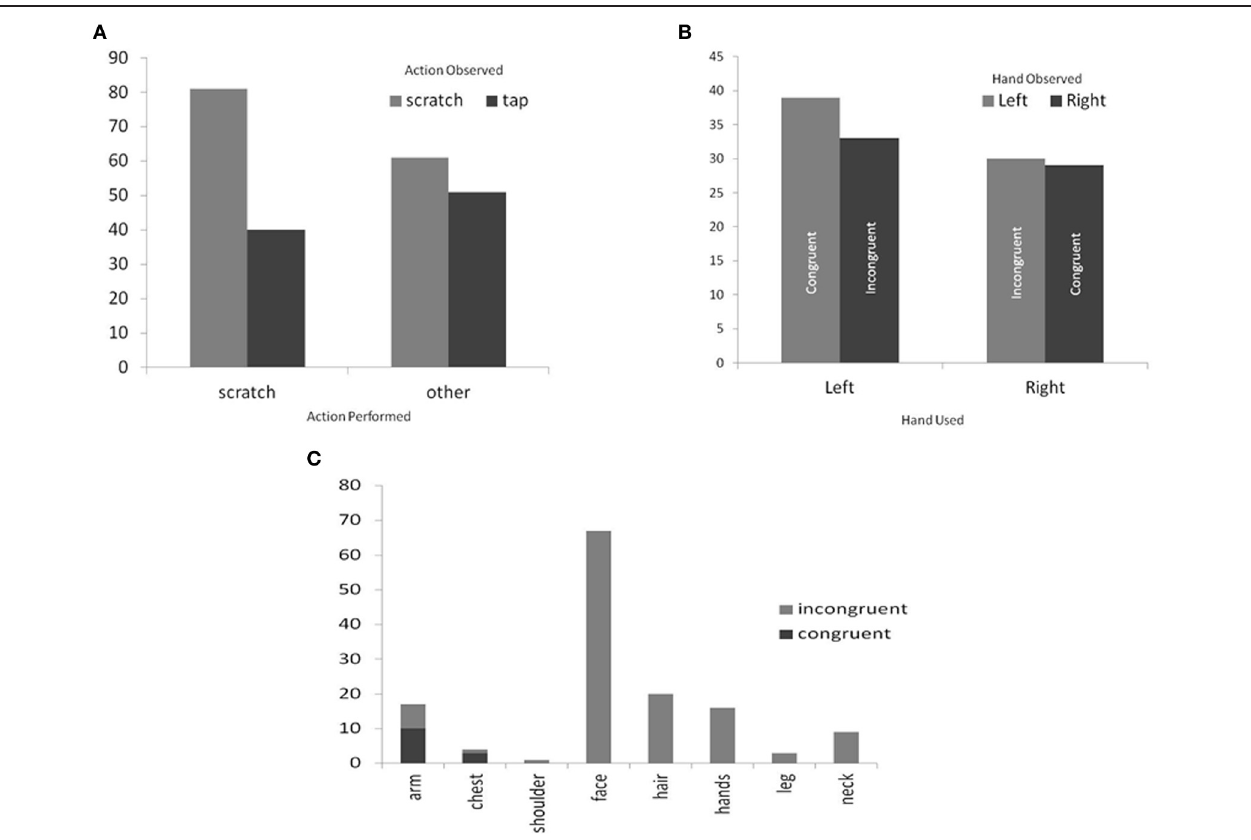
FIGURE 1 | Frequency counts for (A) different actions performed in relation to the current action observed (B) the hand used to perform scratching in relation to the hand observed and (C) the part of the body that was scratched (note: participants only ever saw the arm and torso scratched).